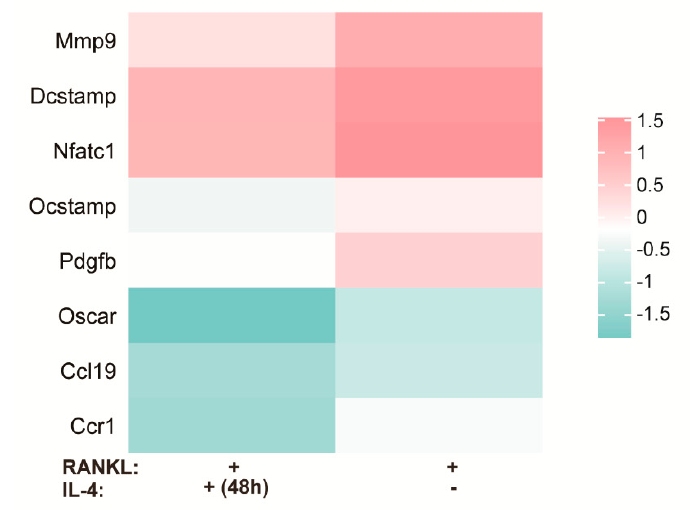
Figure 2. Down-regulated osteoclast differentiation related genes after IL-4 treatment.